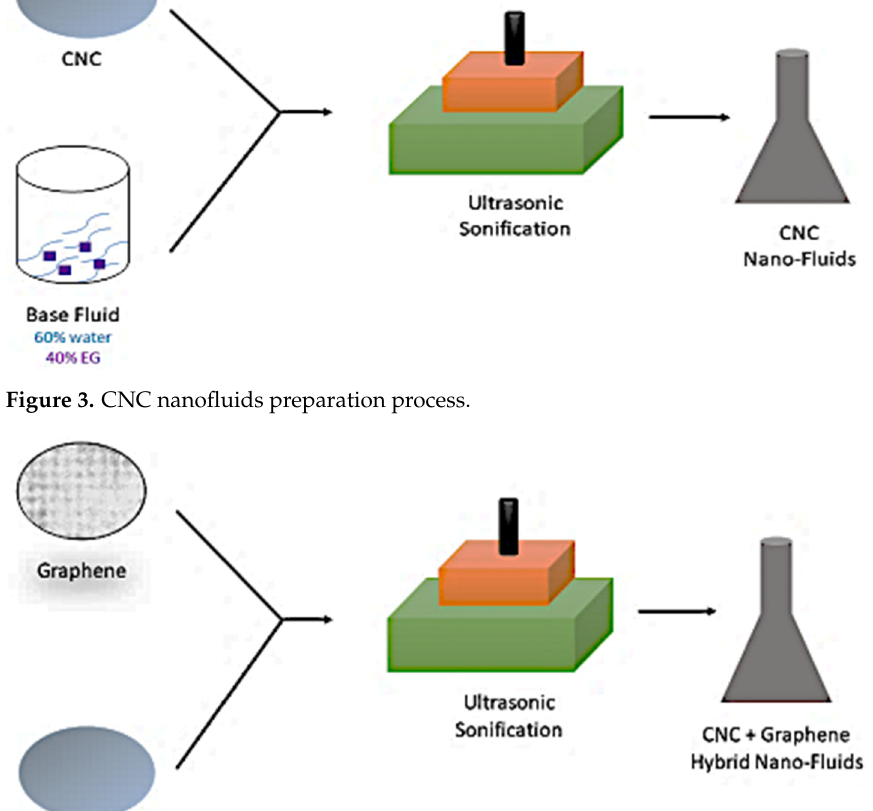
Figure 4. Hybrid nanofluids preparation process from CNC and graphene nanofluids.